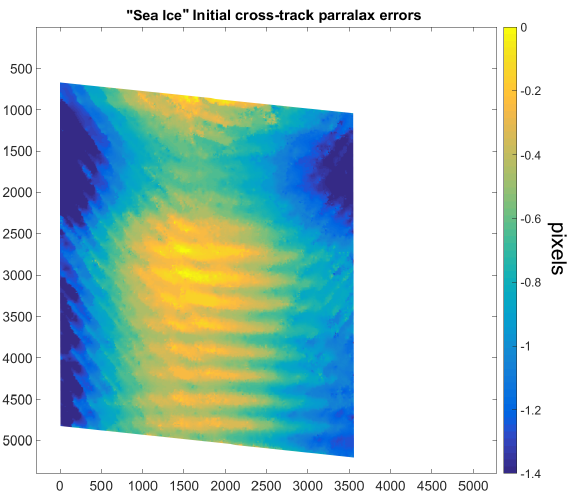
Figure 6: Measure of the combined across-track vibration visi- ble in the backlooking image through bi-dimensional correlation (scene “Sea Ice”) in image space coordinates.